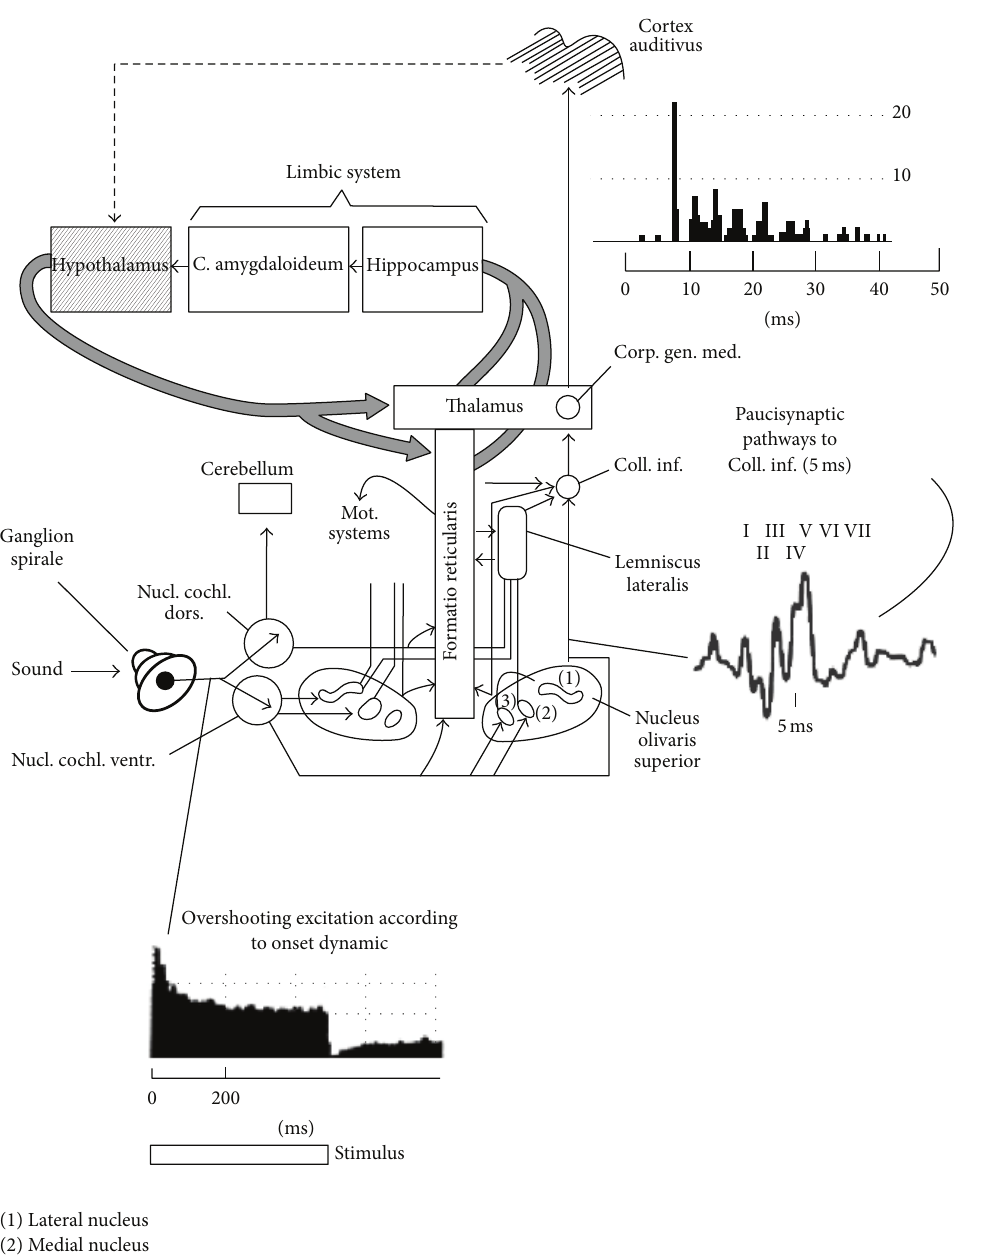
Figure 2: Diagram of the nonclassical auditory pathways showing the relationship between the pathways from the auditory system to the lim- bic system and to the auditory cortex (diagram retrieved from Noise and Health, 2000, http://www.noiseandhealth.org/viewimage.asp?img= NoiseHealth 2000 2 7 49 31742